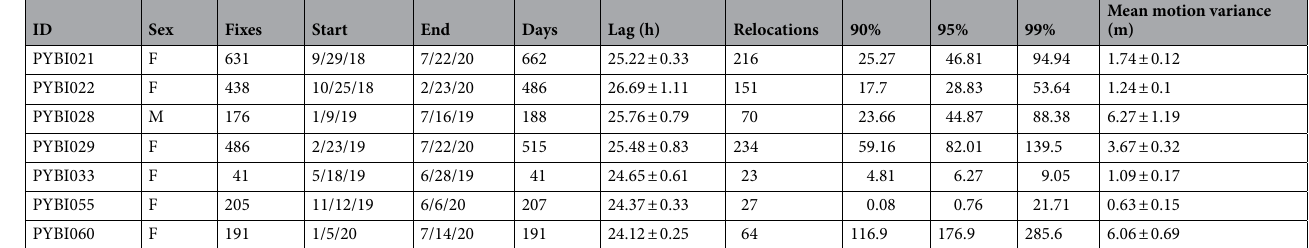
Table 1. Tracking summary for tracked Burmese pythons (Python bivittatus ) in the Sakaerat Biosphere Reserve, Nakhon Ratchasima, Thailand. Summary includes: sex, F, Female, M, Male; fixes, the number of times a python was located and data recorded; start and end date, month/day/year; mean time lag, time in between consecutive telemetry fixes in hours with standard error; relocations, number of times tracked pythons moved from one location to another; 90%, 95% and 99% occurrence distributions (ha), and mean motion variance with standard error.